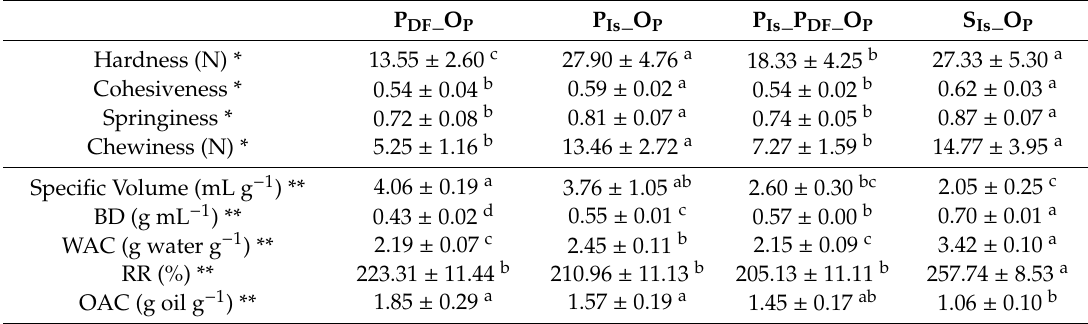
Table 5. TPA and physicochemical and functional properties of meat analogues. P DF _O P : dry-fractionated pea protein and oat protein; P Is _O P : pea protein isolates and oat protein; P DF _P Is _O P : dry-fractionated pea protein, pea protein isolate, and oat protein; S Is _O P : soy isolates and oat